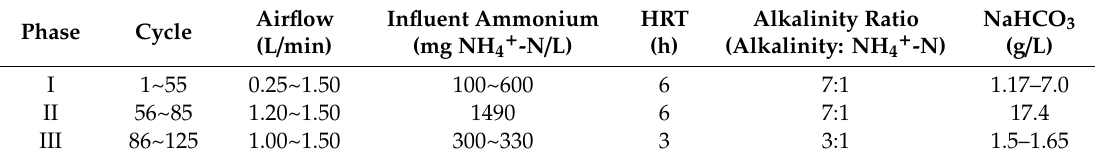
Table 2. Detailed operational conditions during di ff erent stages of the